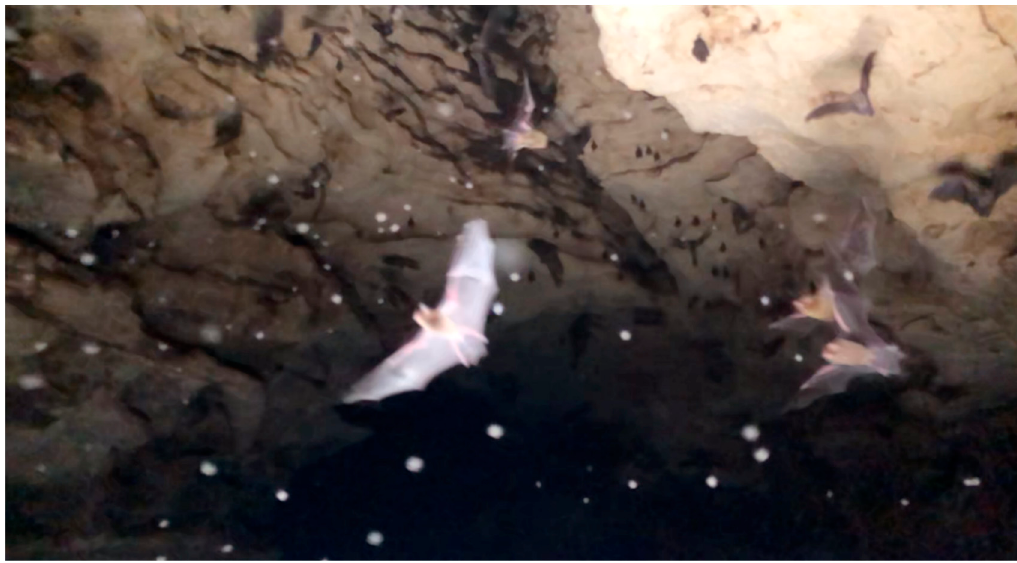
Figure 1. Image of bats filmed by patient 1 (particulate matter seen falling from above in